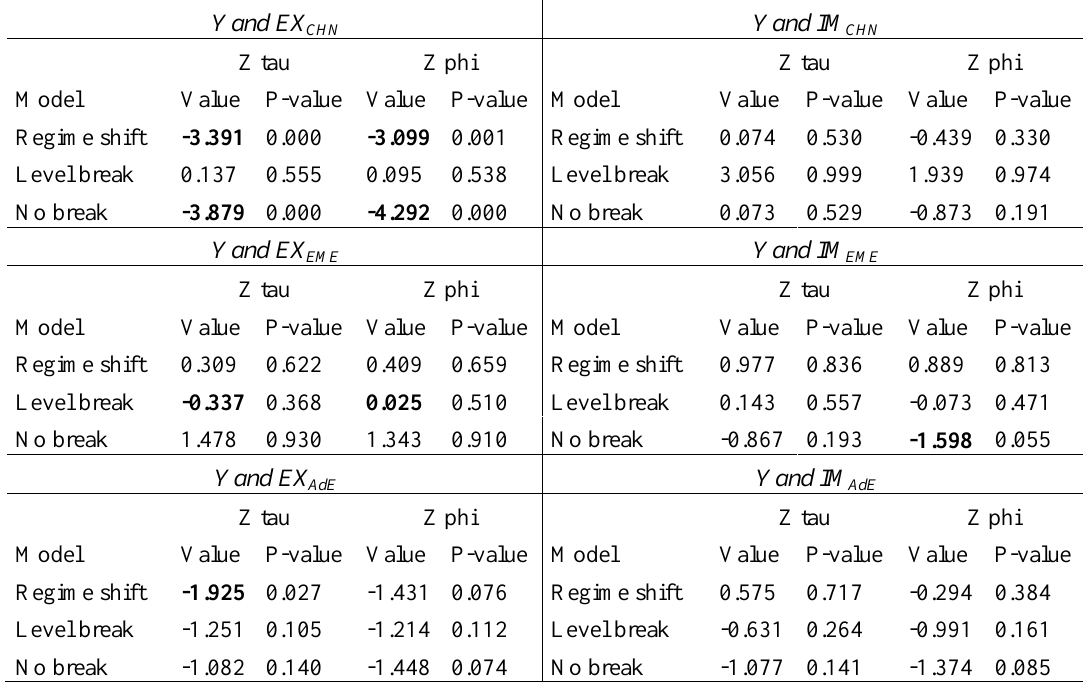
Table 5 : Westerlund and Edgerton (2008) cointegration